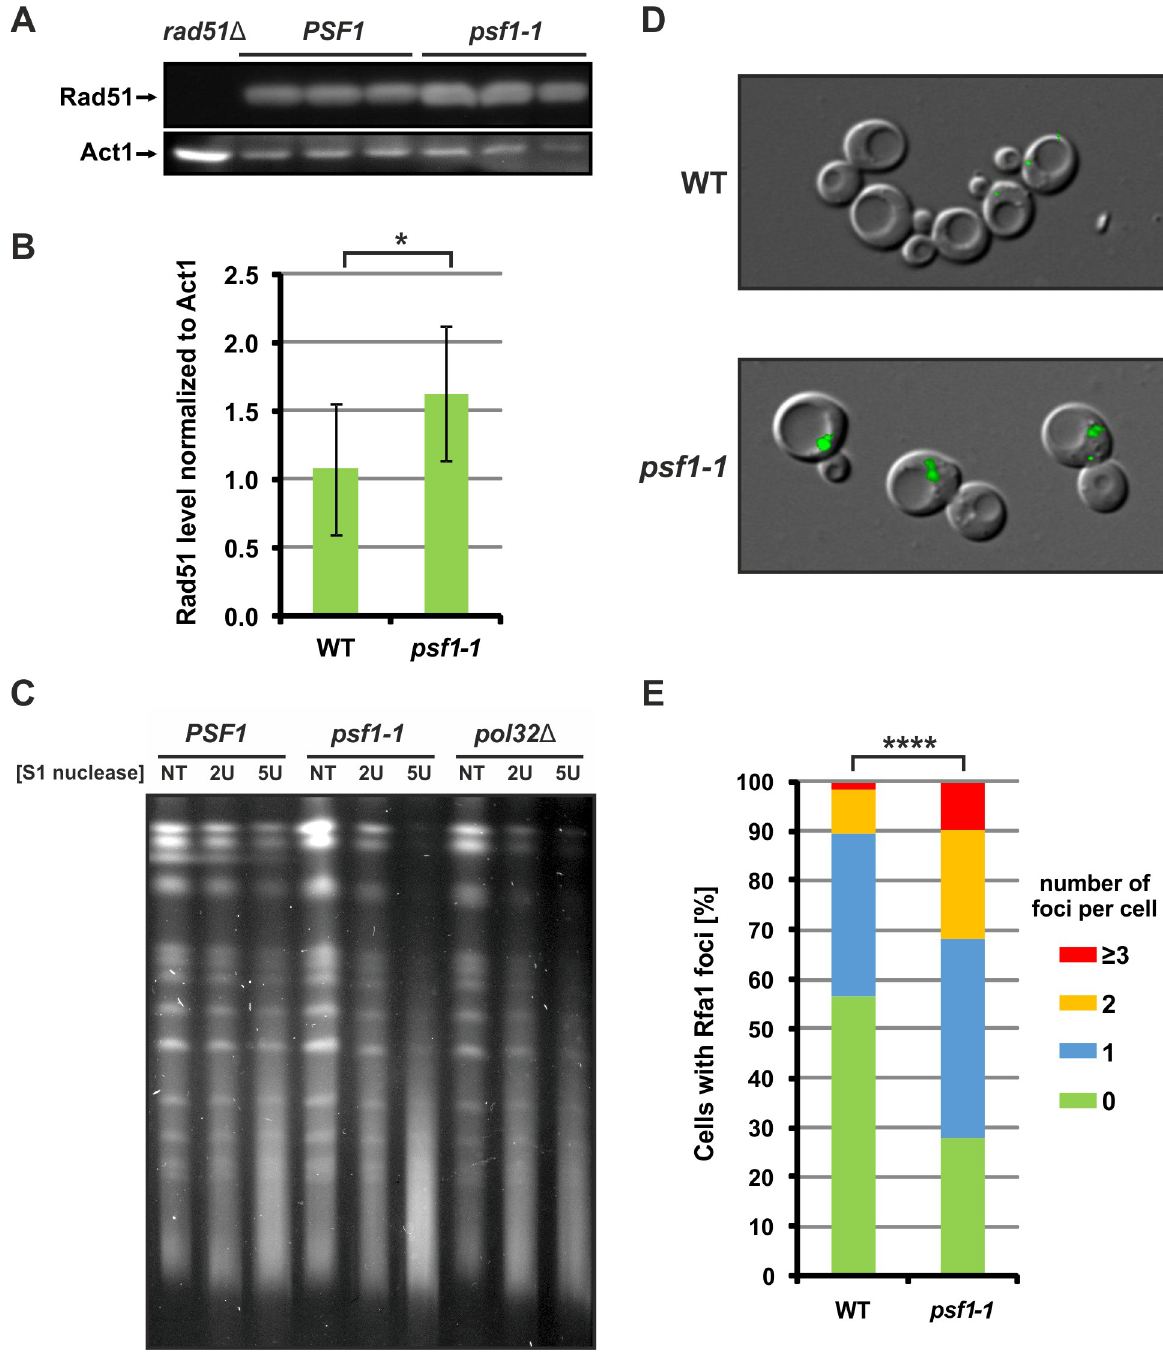
Fig 6. Accumulation of single-stranded DNA and activation of the HR pathway in psf1-1 cells. (A) Rad51 protein levels in the wild-type and psf1-1 strains were analyzed by western blotting with an anti-Rad51 antibody. (B) Quantification of the western blotting results showing the mean ± s.d. of 8 to 12 repetitions of the assay. Strain BY4741 rad51 Δ served as a negative control. Statistical significance was determined with Student’s t- test ( p- value � � 0.05) (C) Pulsed-field gel electrophoresis (PFGE) analysis of chromosome integrity after S1 nuclease treatment of DNA from yeast cells cultured at the permissive temperature 23˚C. Agarose plugs with DNA were treated with two units (2 U) or five units (5 U) of S1 nuclease for 30 min. Untreated plugs are shown as a control (NT). Strain pol32 Δ served as a positive control. (D) Rfa1–YFP foci detected in wild-type and psf1- 1 strains. (E) Rfa1 foci frequency quantification. Three biological replicates were performed, each with at least 200 cells counted. The results represent the number of cells with indicated number of foci with SD. For statistical analysis contingency table and the chi-square test were used (S2 Table). The chi-square statistic is 223.4038, which corresponds to the p -value ���� < 0.0001.